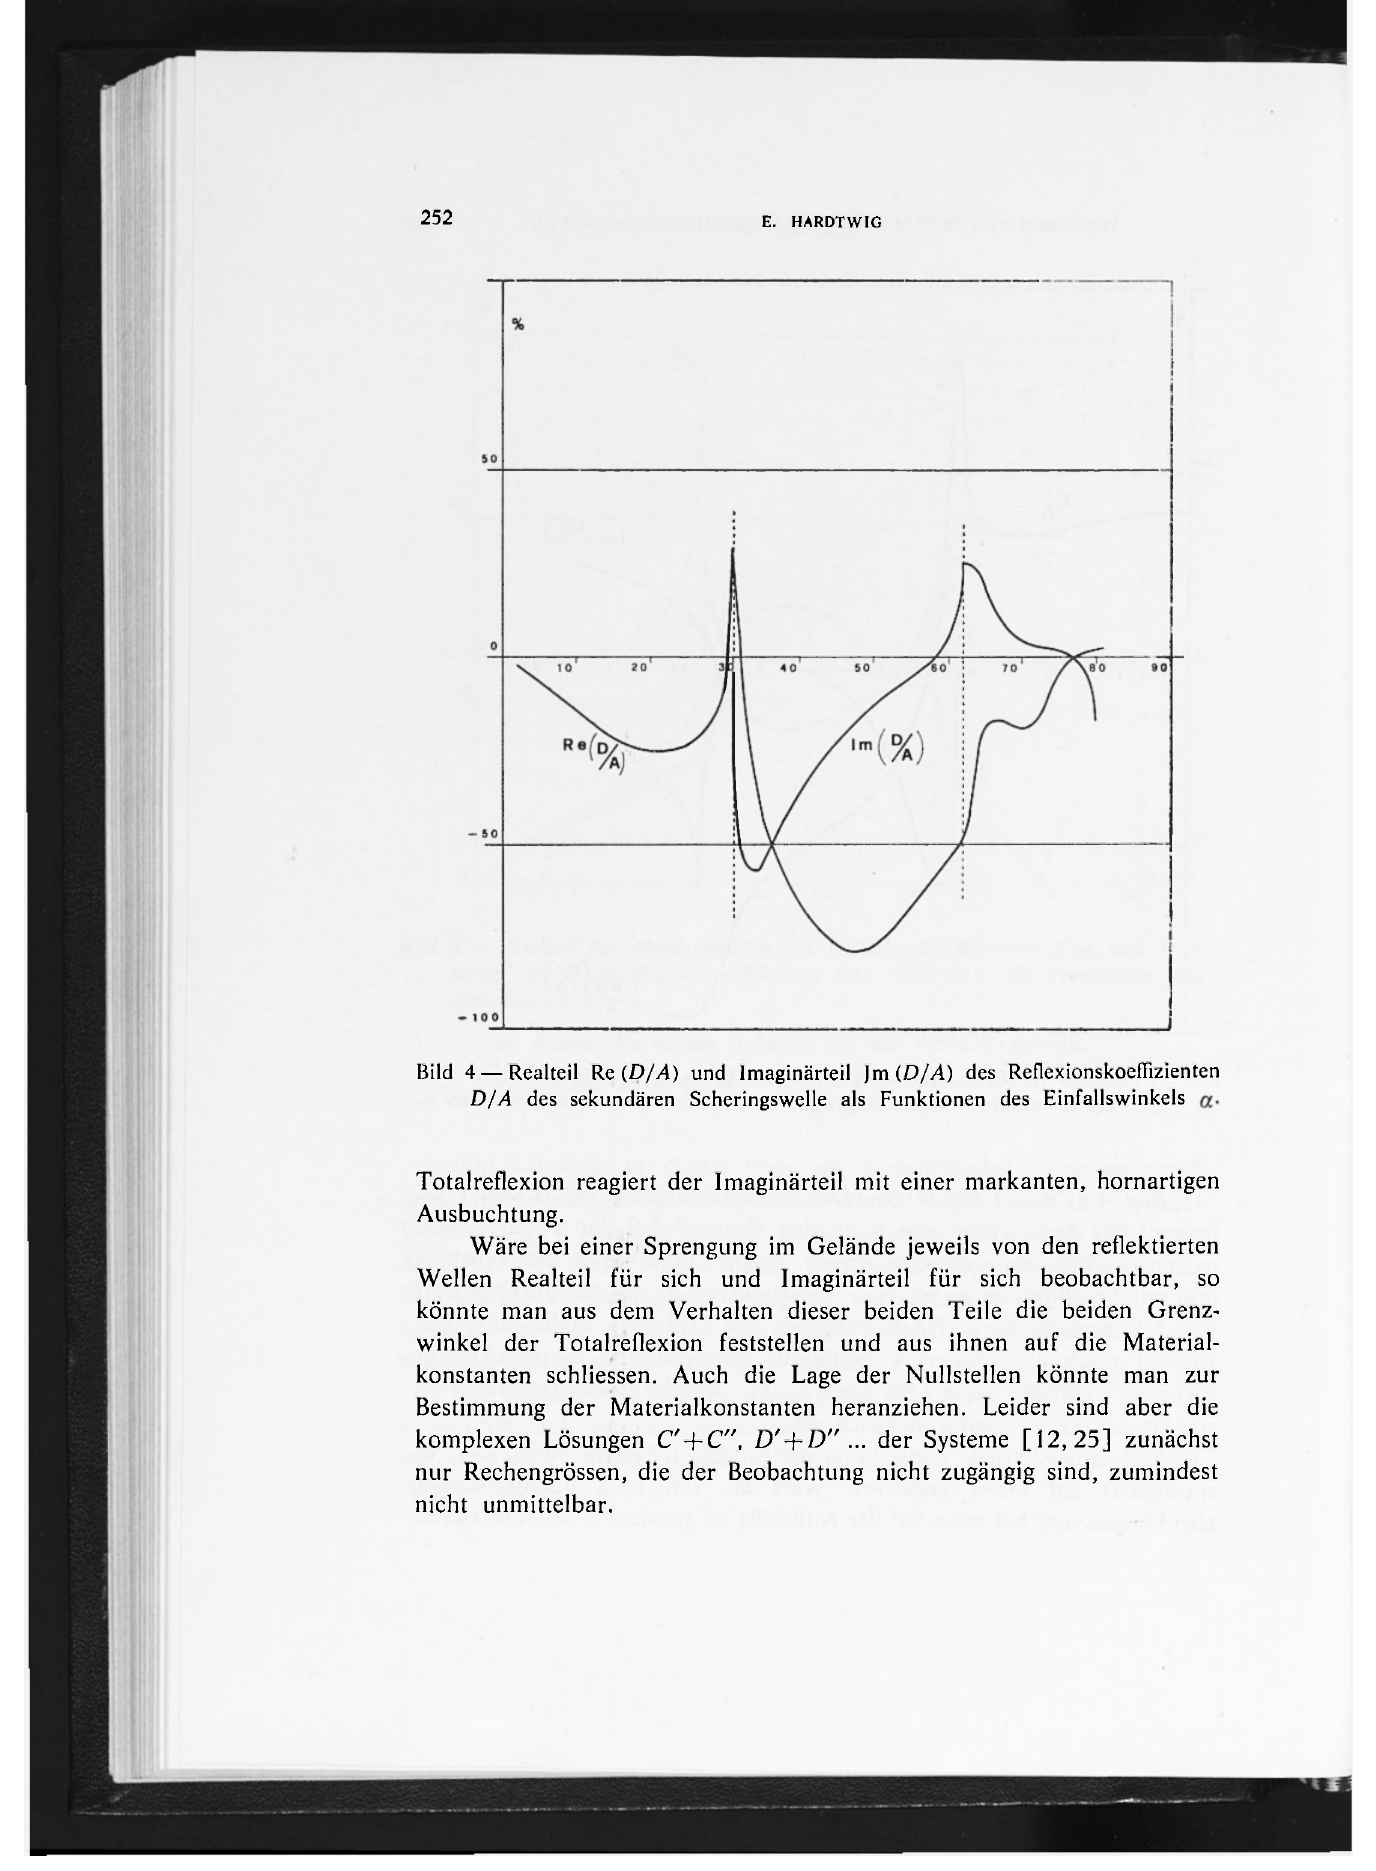
Bild 4— Realteil Re